Question: Write a single sentence explaining what this figure depicts.
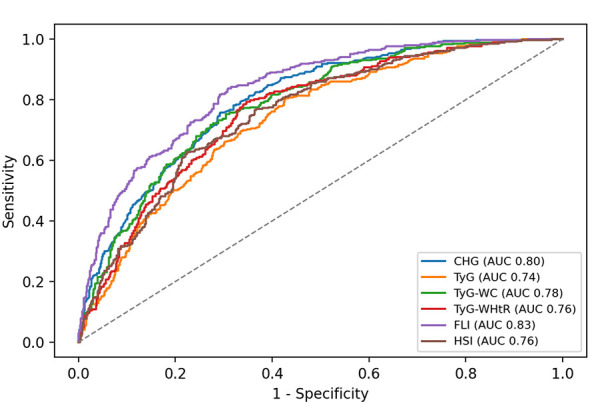
Answer: ROC curves for CHG and selected comparator indices.